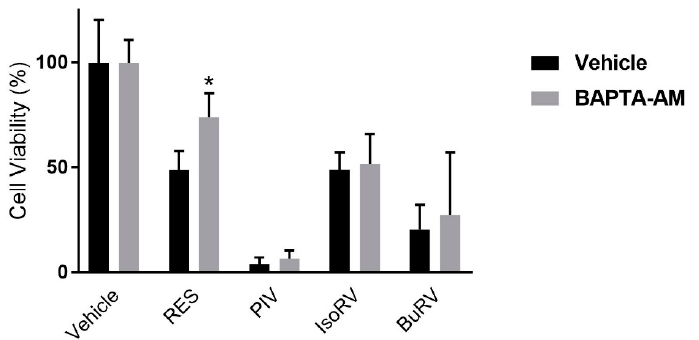
Figure 3. RES-induced decrease in cell viability is dependent on an increase in intracellular calcium. MDA-MB-231 cells were pretreated with 10 μ M BAPTA-AM (gray bars) or a vehicle control (black bars). After the 15-min pretreatment, the cells were given the compound indicated on the x -axis. The data